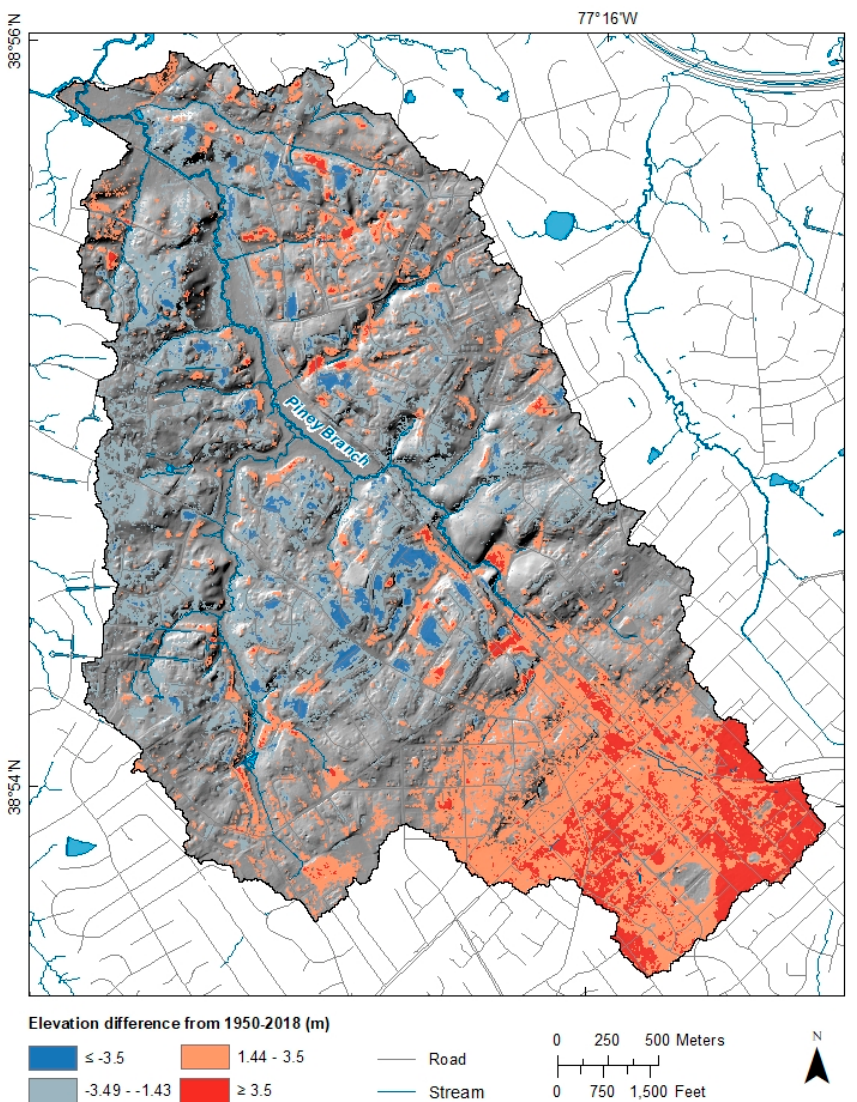
Figure 7. DEM of Difference (DoD) result from 1950 to 2018 analysis of topographic change for Piney Branch watershed. Elevation loss is symbolized in blue, while elevation gain is symbolized in red. Table 5. Evaluation of topographic change thresholds associated with different temporal intervals.